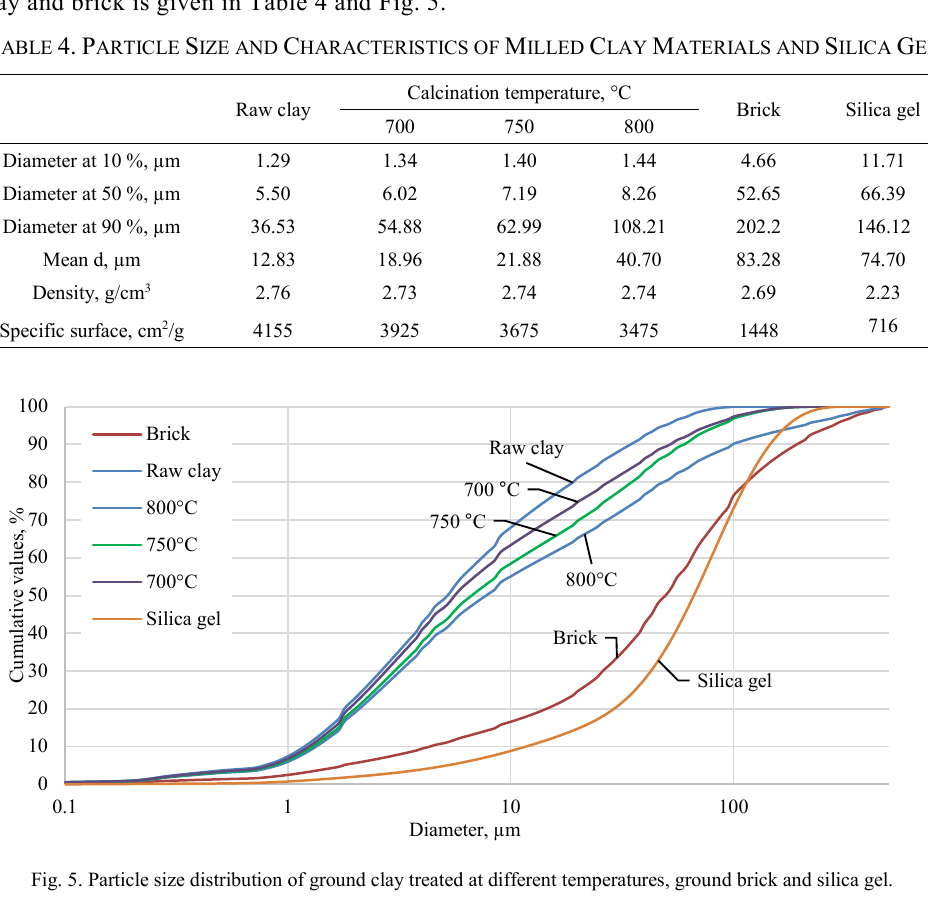
Fig. 5. Particle size distribution of ground clay treated at different temperatures, ground brick and silica gel. Collision milling technique using disintegrator is described in previous paper [26]. The same grinding parameters was used both for raw clay and waste brick. Then raw clay was heated at temperatures of 700, 750 and 800 °C and particle size distribution was determined and compared. Results indicate that the finest state was for raw clay. d 10 was 1.29 µm, d 50 was 5.50 µm and d 90 was 36.53 µm. Heating of ground raw clay powder gradually increased particle size and for red clay treated at 800 °C was characterized by d 10 1.44 µm, d 50 8.26